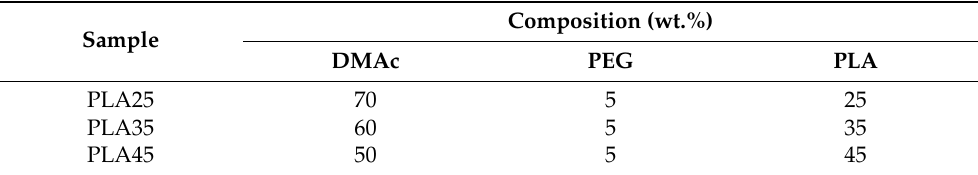
Table 1. Composition parameters of the three spinning solutions used in this